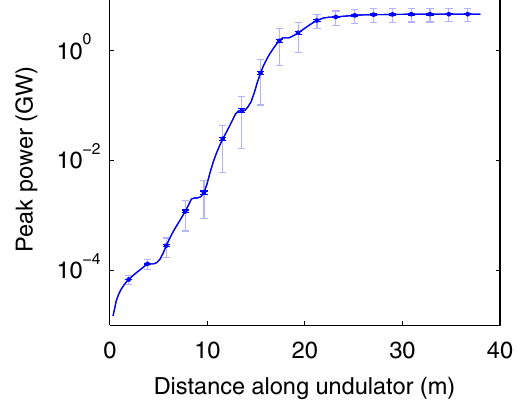
FIG. 10. Mean power growth along the undulator for 100 shot- noise seeds. Bold error bars show the error on the mean value; faint error bars show standard deviation.